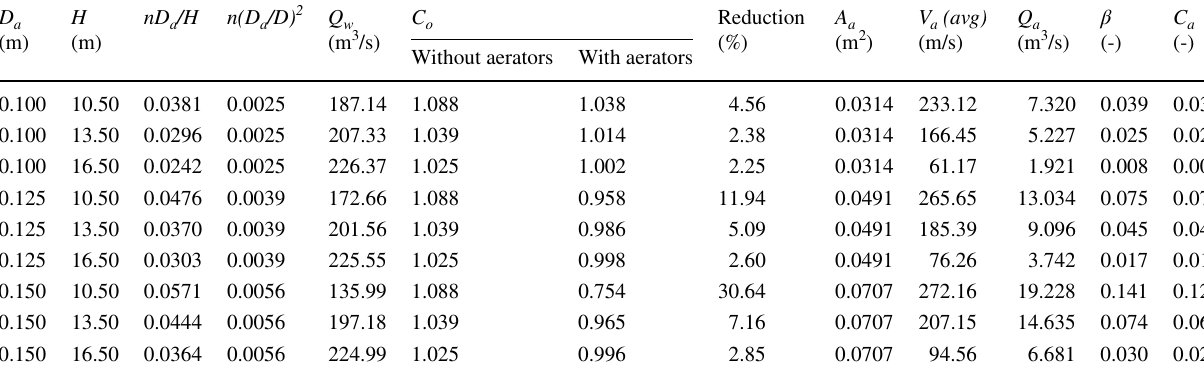
Fig. 8 Comparison velocity distributions along the edge of spillway profile and centerline of the shaft at maximum ( H = 16.5 m) and min ( H = 10.5 m) operating heads for different aeration diameters Table 2 Effects of aerators on spillway discharge and aeration